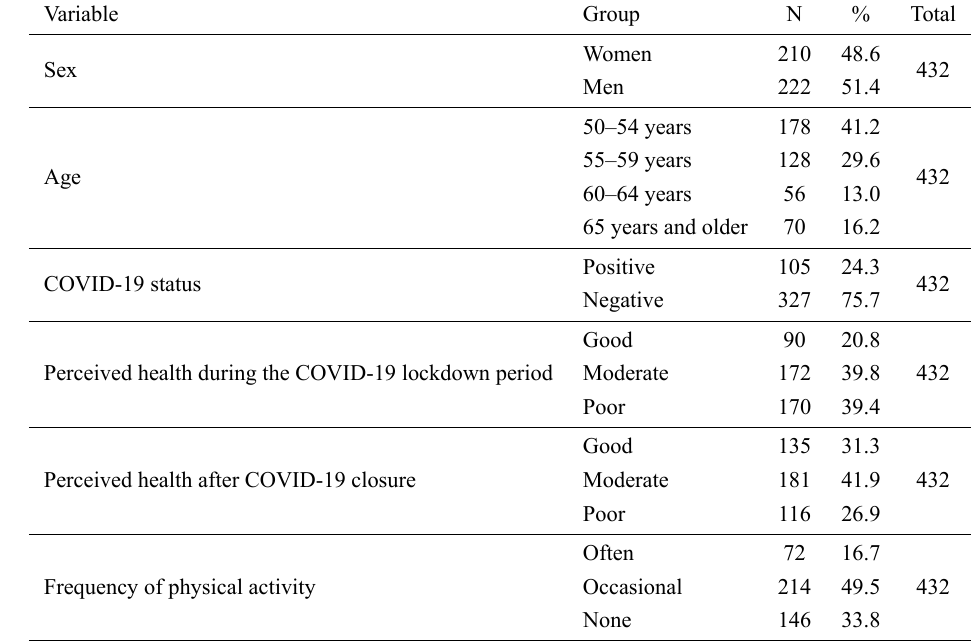
Table 1. Distribution of the participants according to their answers to the questions in the personal information form.